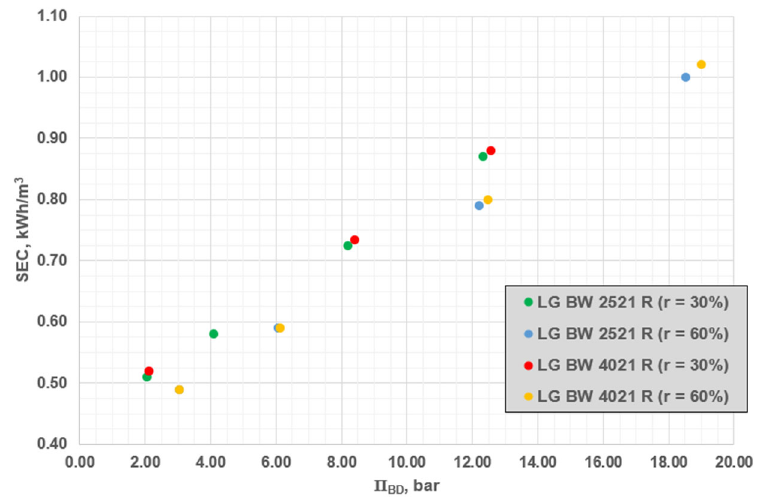
Figure 4. Estimated main SEC at 30 and 60% recovery rates based on the reported results from Q+ simulations with LG BW 2521R and 4021ES membrane elements.